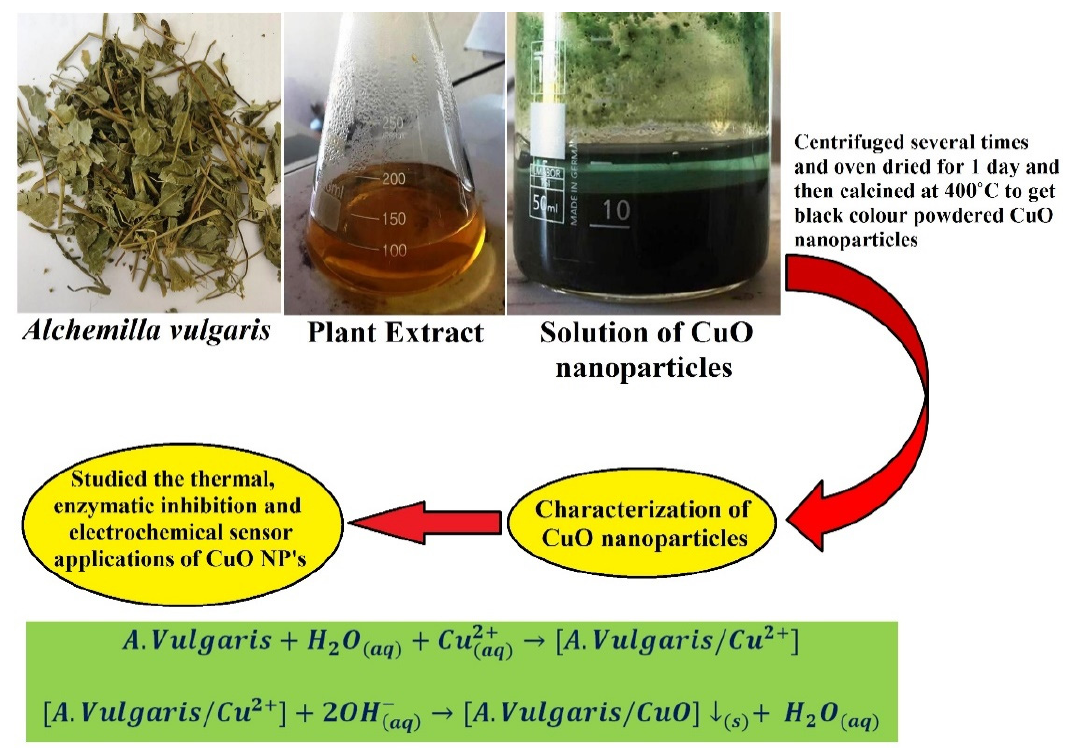
Figure 1. Experimental flowchart of green synthesis of CuO NPs using Alchemilla vulgaris leaves.